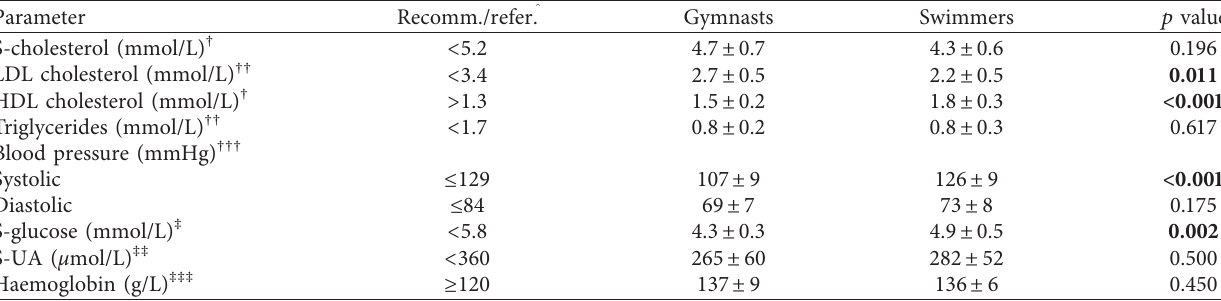
Table 4: Cardiovascular (CV) health and safety factors compared among elite-level artistic gymnasts and swimmers. Parameter Recomm./refer.